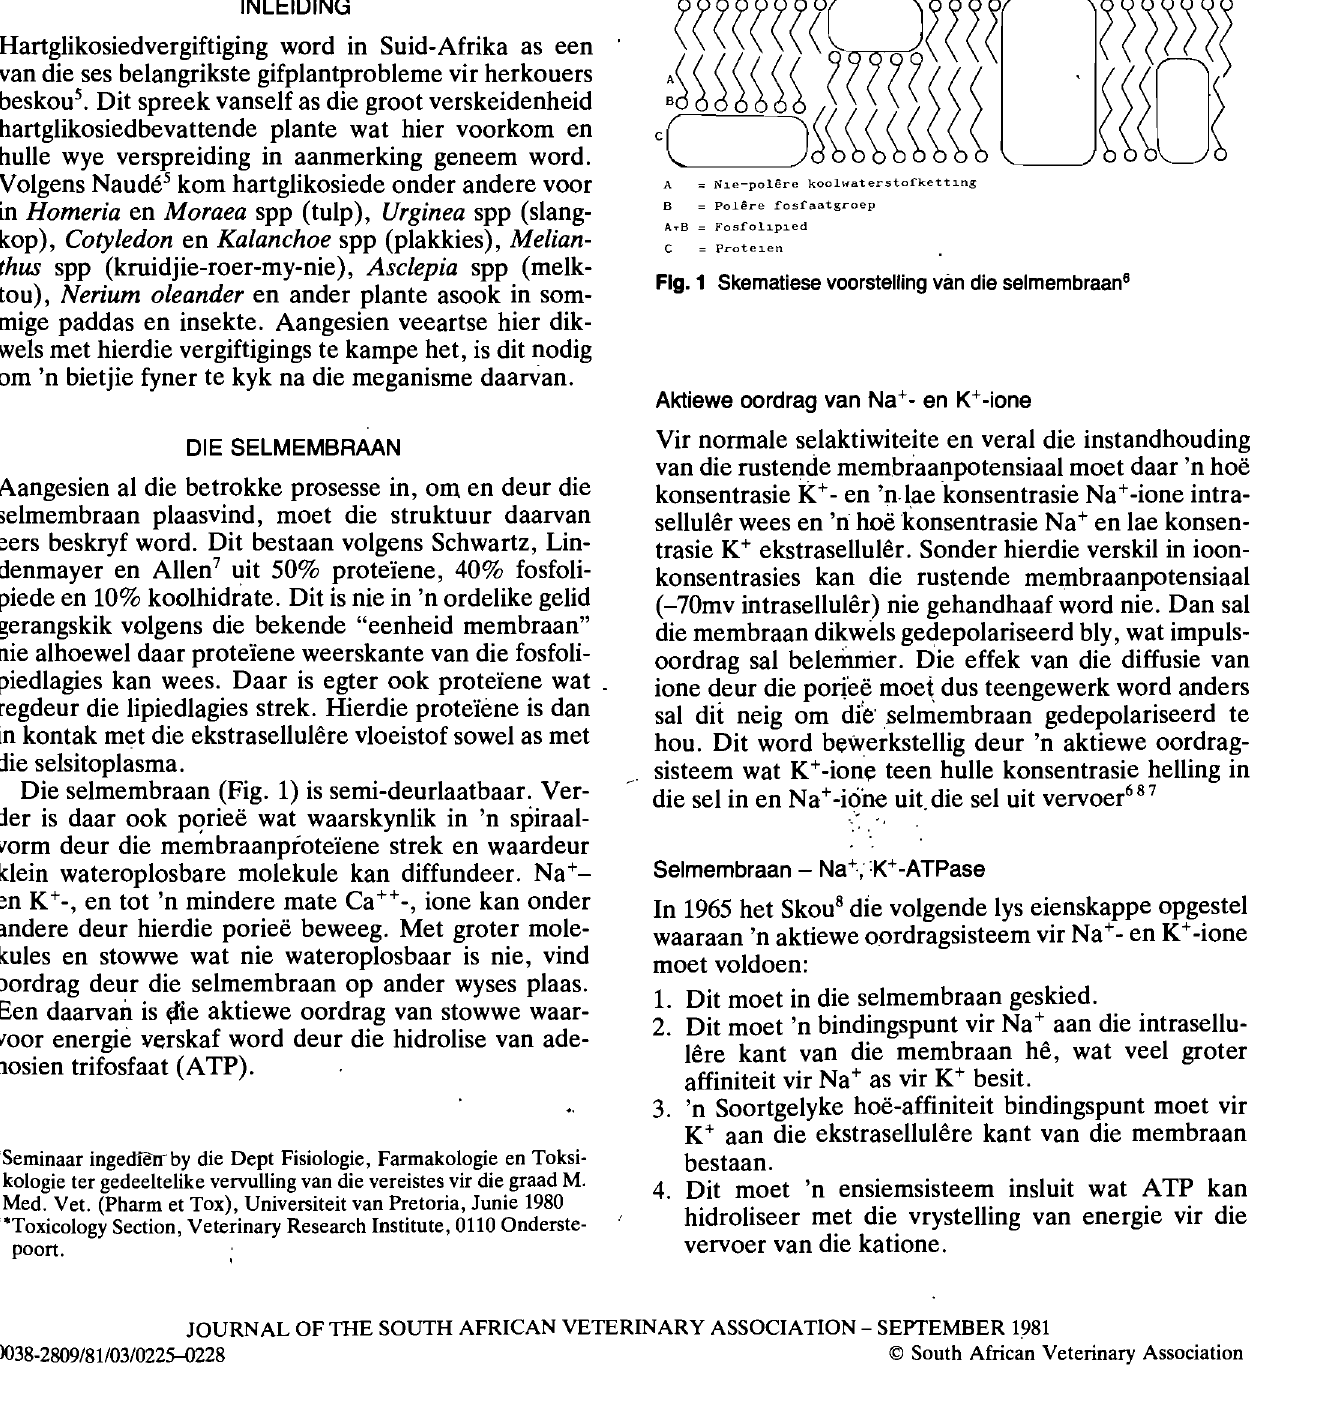
Fig. 1 Skematiese voorstelling van die selmembraan 6